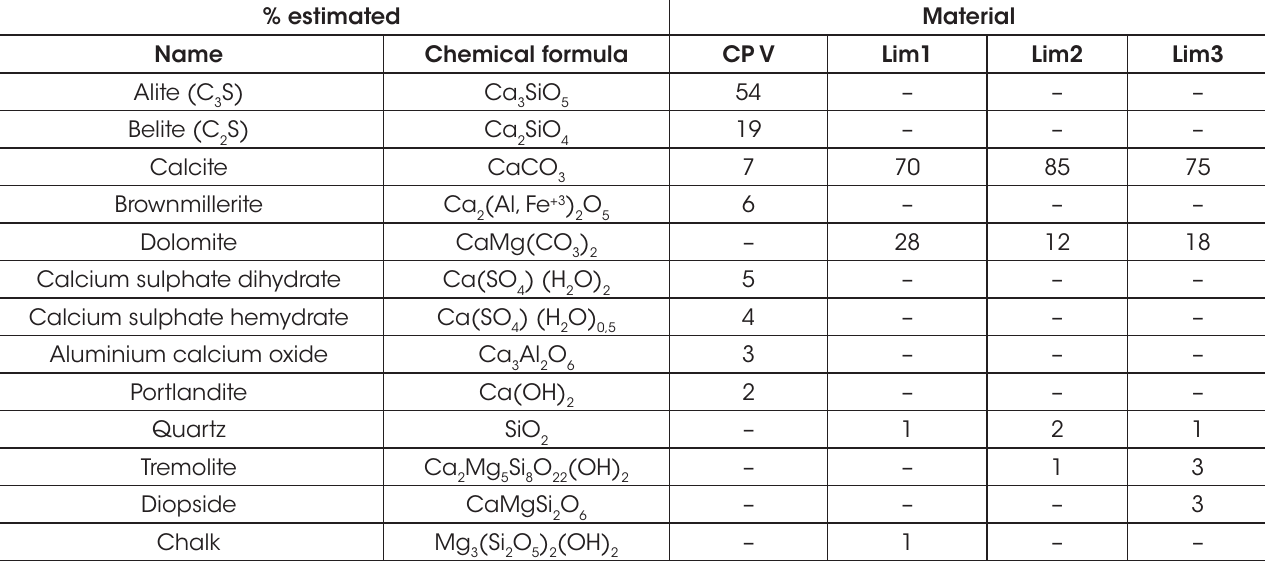
Mineralogical characterization of materials by X-ray diffraction – Rietveld quantitative method %